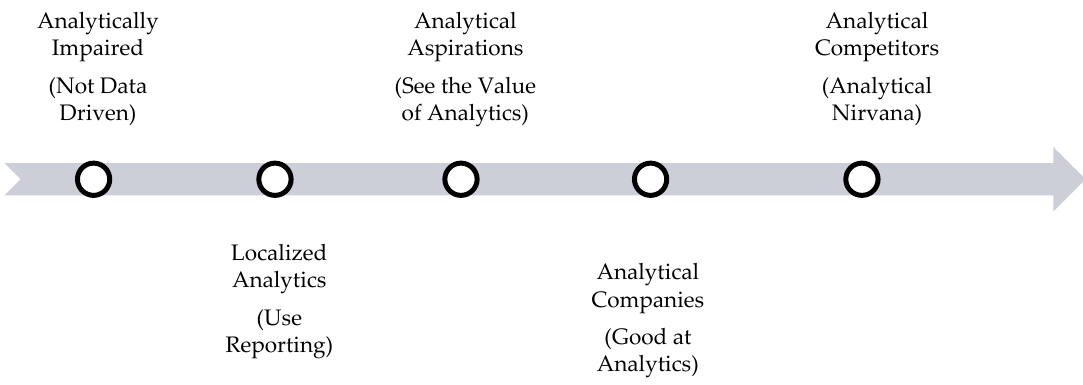
Figure 7. Analytics continuum — Delta Plus Model. Source: own elaboration based on [29,31].